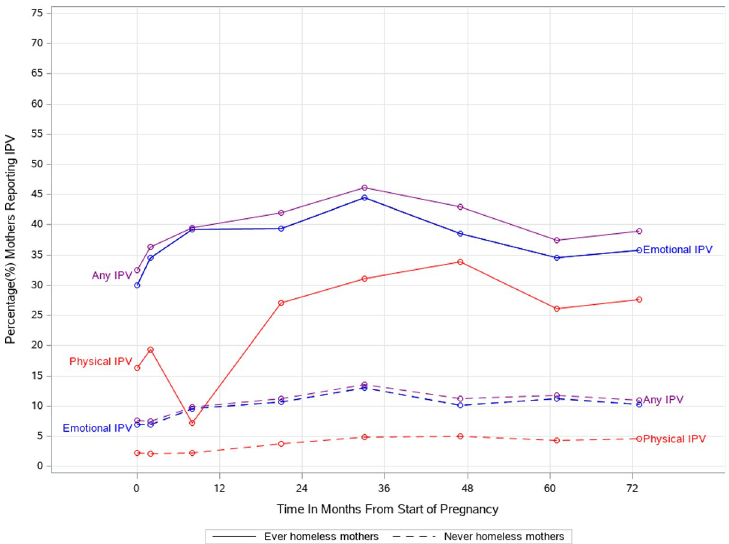
Fig 1. Prevalence of IPV among mothers in 82 months following start of pregnancy, stratified by homeless status.